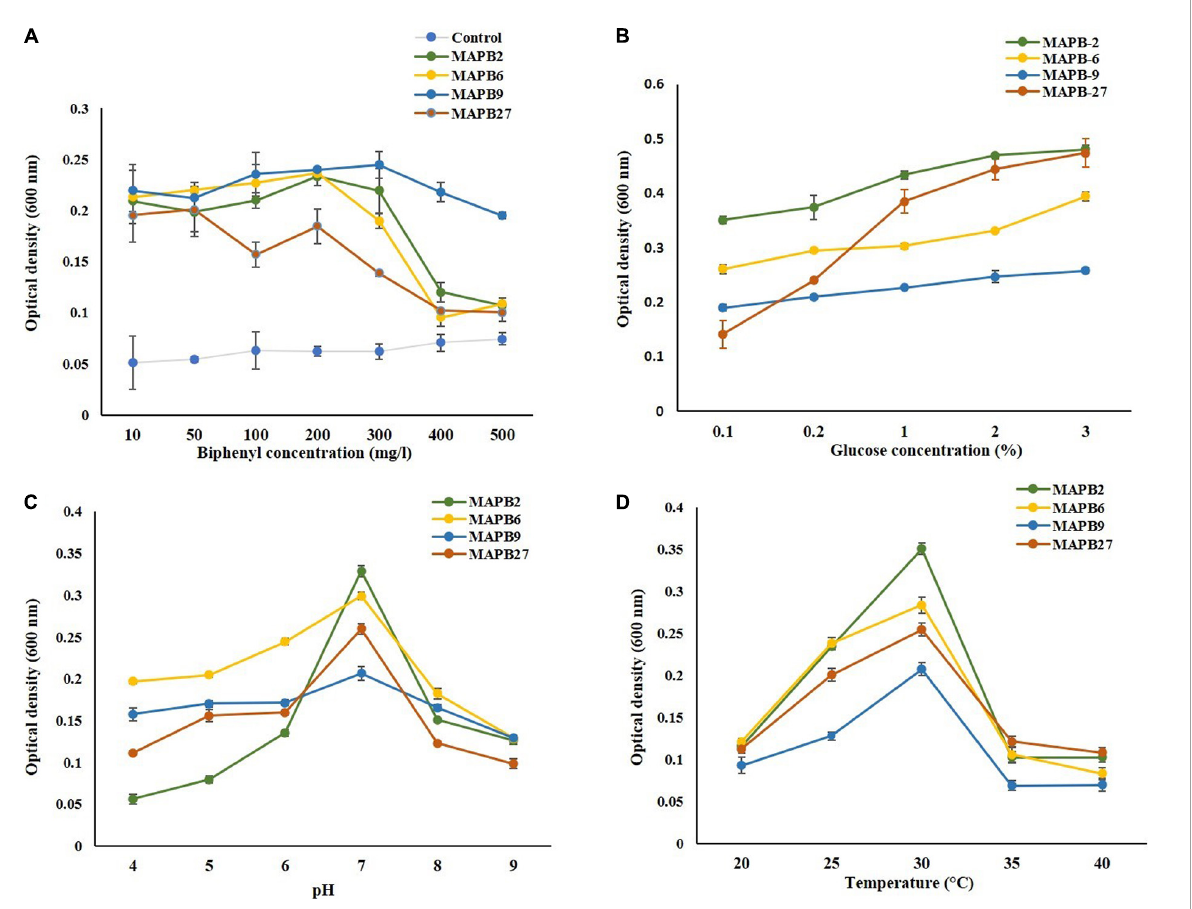
FIGURE2 Optimization of the growth parameter for potential PCB degrading bacterial isolates grown in minimal medium in 48 h (A) biphenyl concentration range (10–500 mg/l) (B) glucose conc. (0.1–3%) with 200 mg/l biphenyl (C) pH (4-9) and (D) temperature (20–40 ◦